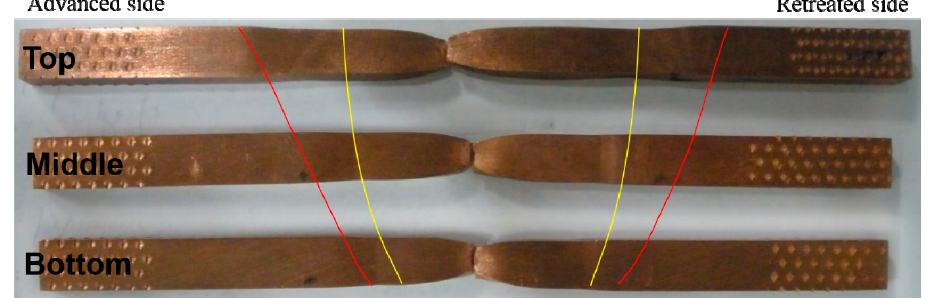
Figure 9. Typical fracture location of the FSW CuCrZr alloy joints.